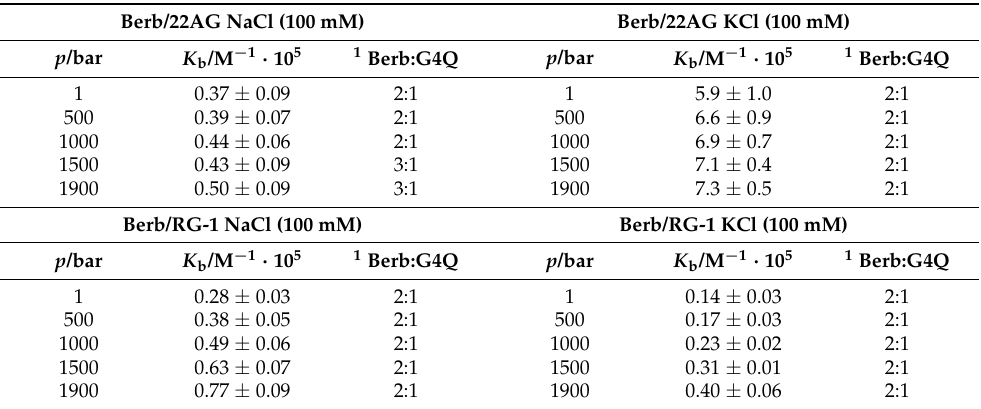
Table 2. Binding constants, K b , and stoichiometries for the complex formation between berberine and G4Qs (22AG and RG-1) for the indicated solution conditions and at pressures of 1, 500, 1000, 1500, and 1900 bar ( T = 25 ◦